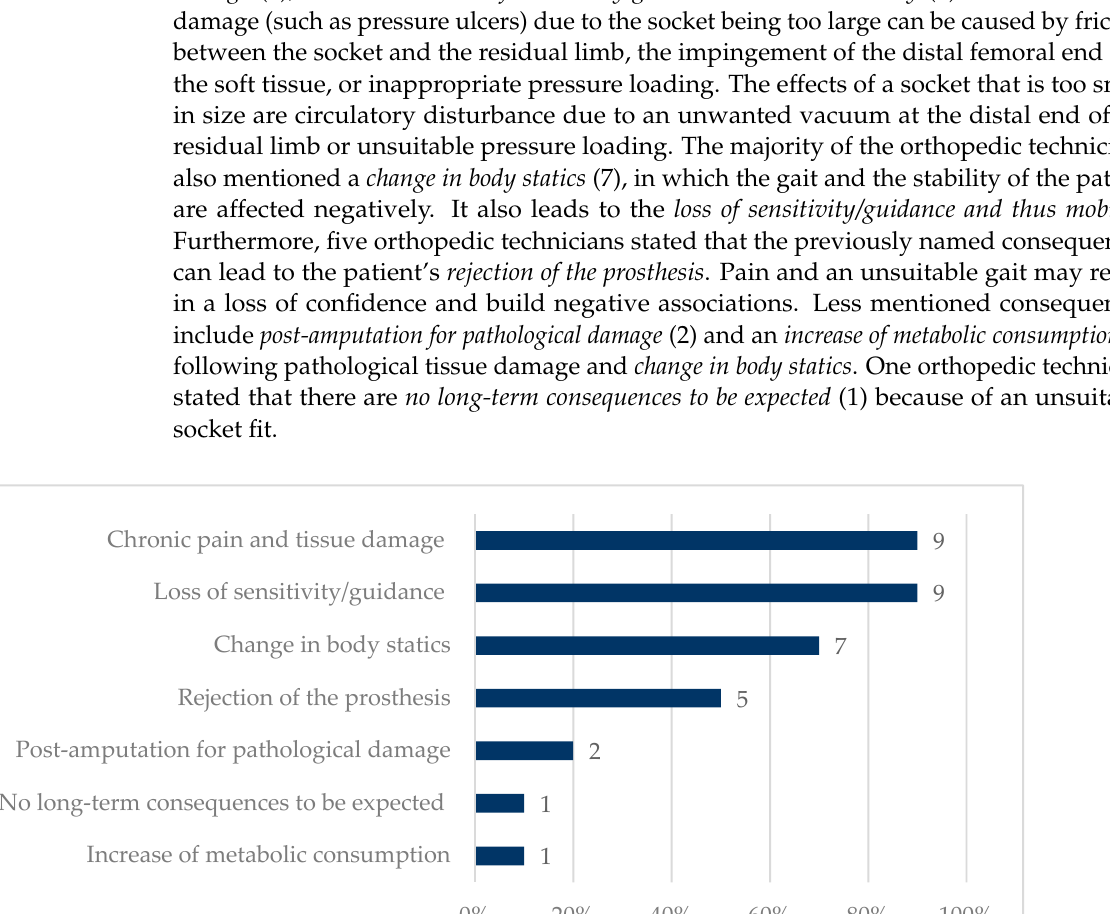
8 Table 1. Parameters for evaluating the socket and fit of the prosthesis. Parameters for Evaluating the Socket and Fit of the Prosthesis